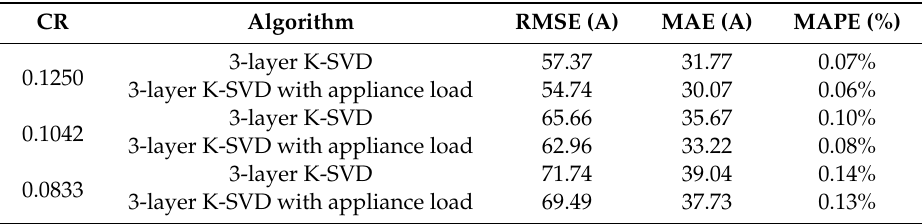
Table 1. Reconstruction performance comparison with different sparse coding algorithms.